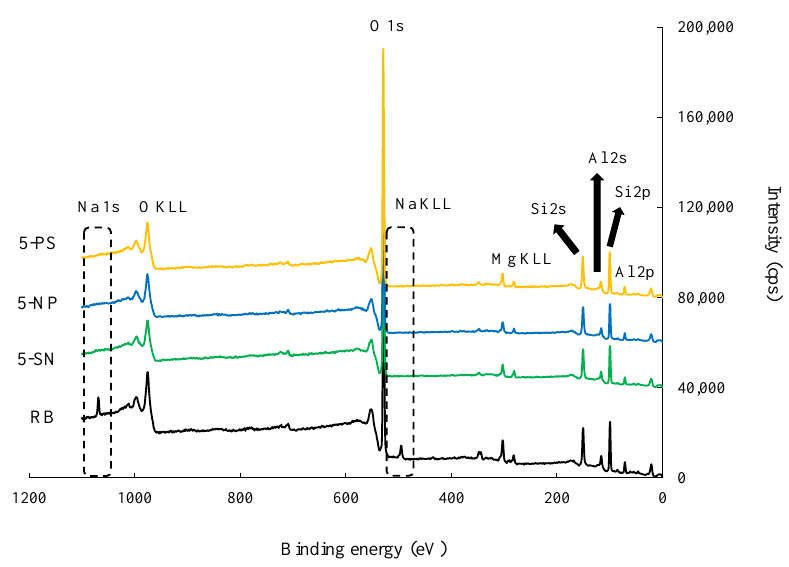
Figure 3. Binding energies of RB, 5-SN, 5-NP, and 5-PS.